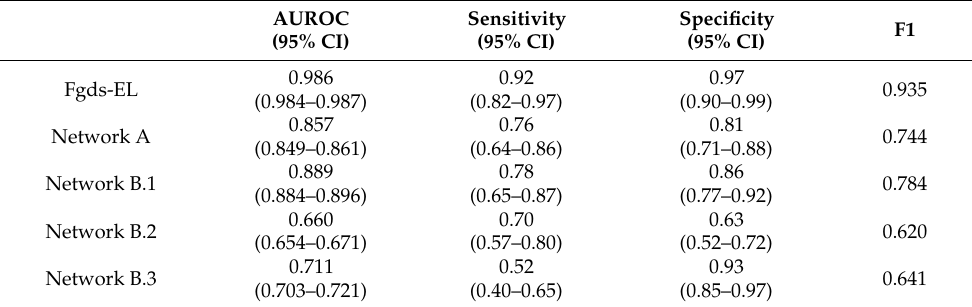
Figure 3. Performance of different deep learning algorithms in discerning fetal genetic diseases. ( a ) The receiver operating characteristic (ROC) curves of the different sub-networks and Fgds-EL in the test set. ( b ) The ROC curves of the different deep learning algorithms in the test set. AUC is the area under the ROC curve. Table 2. Fgds-EL performance in screening and identifying genetic